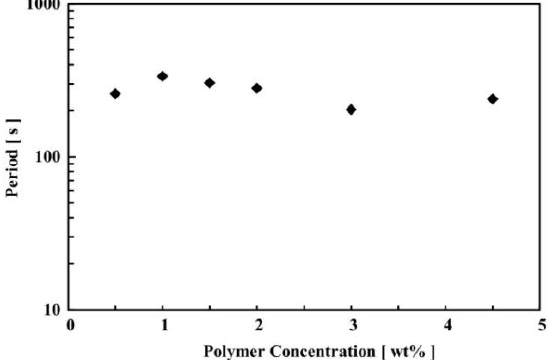
Figure 8. Dependence of self-oscillation period on concentration of poly(VP- co -Ru(bpy) solution under fixed concentrations of the three BZ substrates ([MA] = 0.0625 M